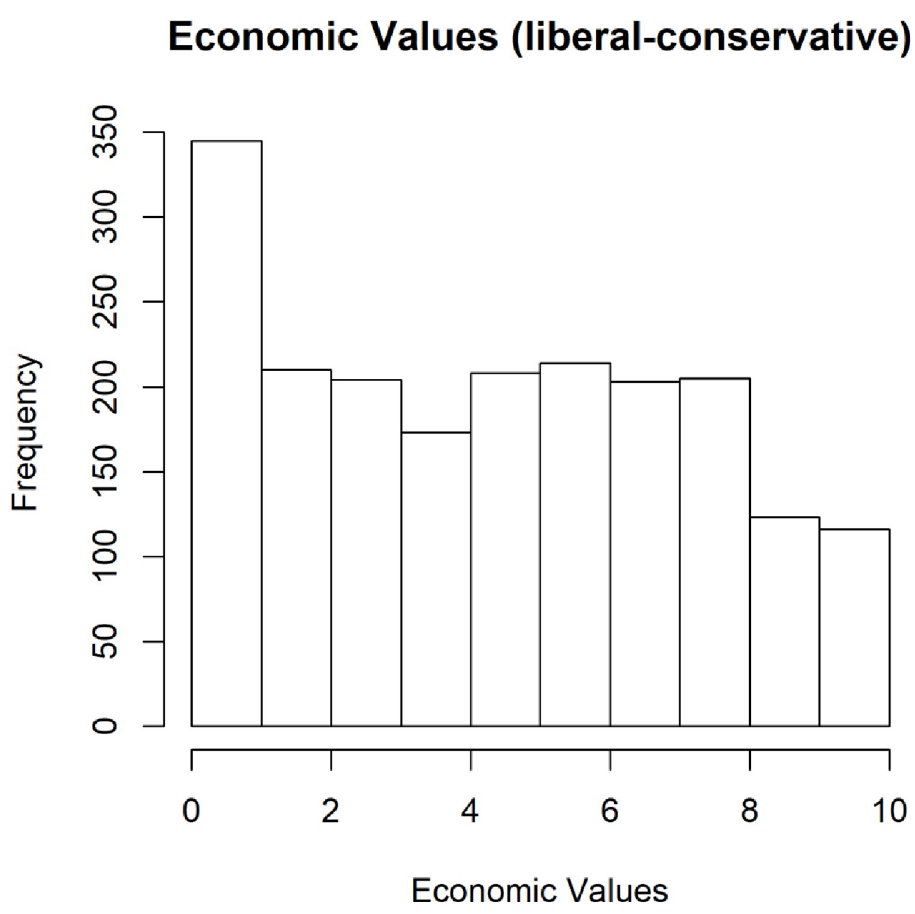
Fig 4. Participants by self-reported economic values (0-most liberal; 10-most